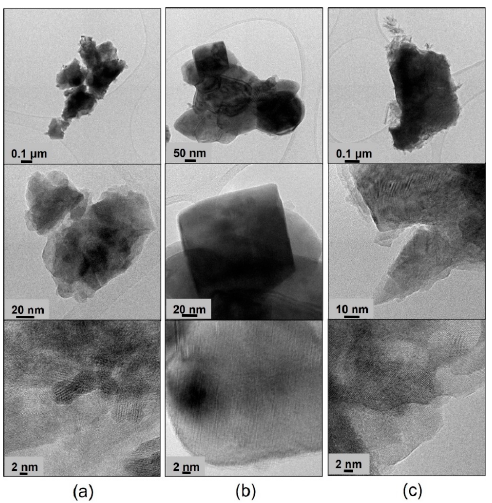
Figure 2. Low-(up), medium-(middle) and high-(down) resolution TEM images of BP-HET ( a ), Figure 2. Low- (up), medium- (middle) and high-(down) resolution TEM images of BP-HET ( a ), LSCF900 ( b ) and BSCF900 ( c ). LSCF900 ( b ) and BSCF900 ( c